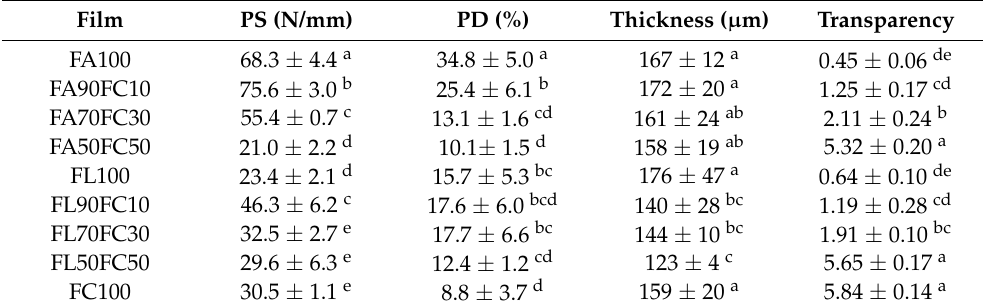
Table 2. Puncture strength (PS), puncture deformation (PD), and thickness of the films. ANOVA and LSD were performed. Different letters in the same column indicate significant differences ( p <